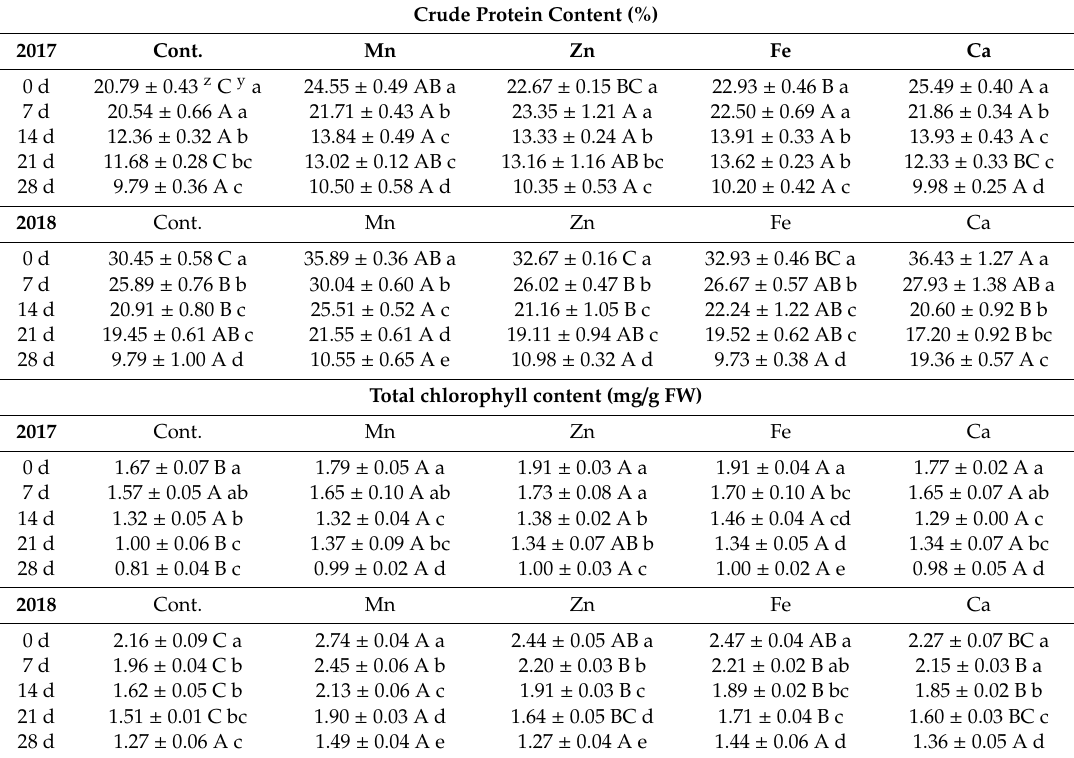
Table 3. E ff ect of foliar application of Ca, Mn, Zn, Fe elements plus water as the control on crude protein and total chlorophyll of broccoli florets stored for 28 days at 4 ◦ C. Crude Protein Content